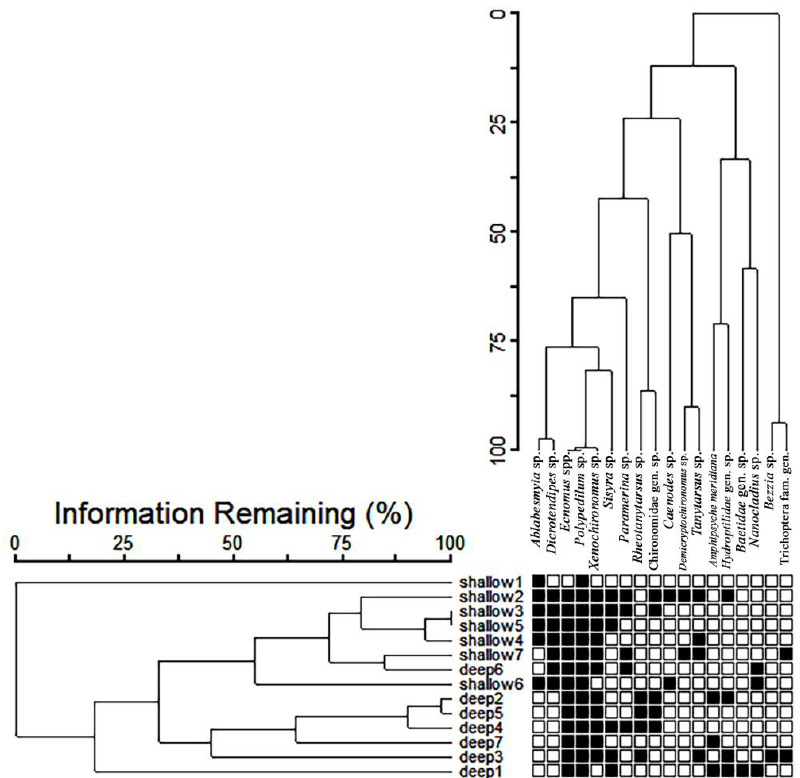
Diversity 2022 , 14 , x FOR PEER REVIEW Figure 7. Occurrence and composition of sponge-dwelling larvae of aquatic insects associated with 14 samples of Corvospongilla siamensis (Pong River, Lower Mekong). One cluster comprised the shallow-water samples (0.3 m) and the other all but one of those from deep water (1 m).